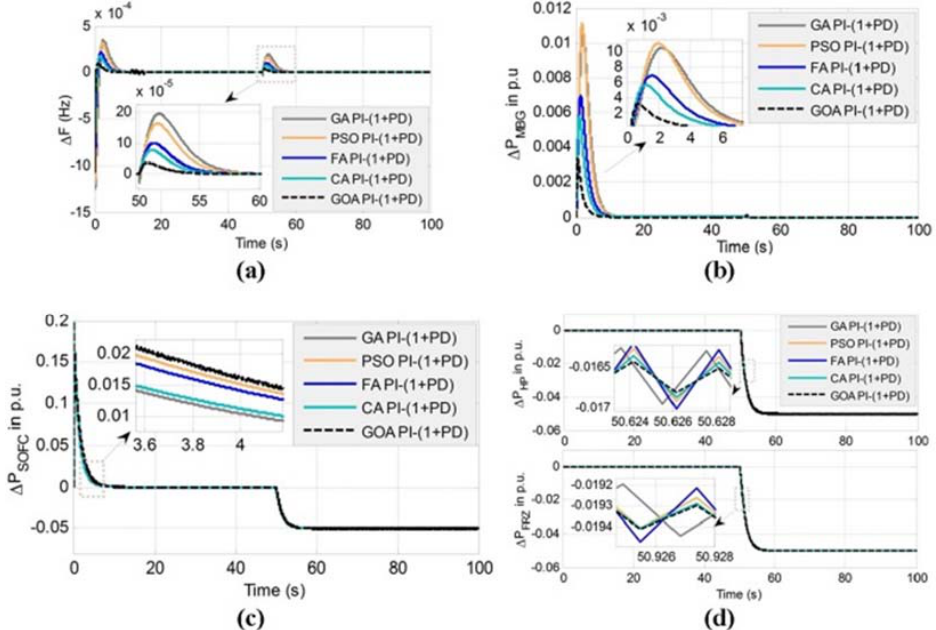
Figure 8. Optimization of controller parameters for frequency stability and minimum power exchange from fuel cell and generator [19]. ( a ) change in frequency, ( b ) change in power output of generator, ( c ) change in power output of fuel cell, ( d ) changes in power received by non-sensitive